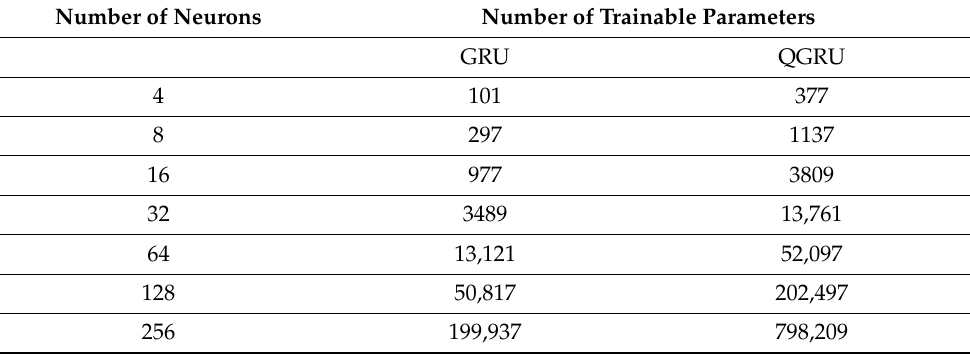
Table 3. The number of trainable parameters across various numbers of neurons used in the vehicle localisation